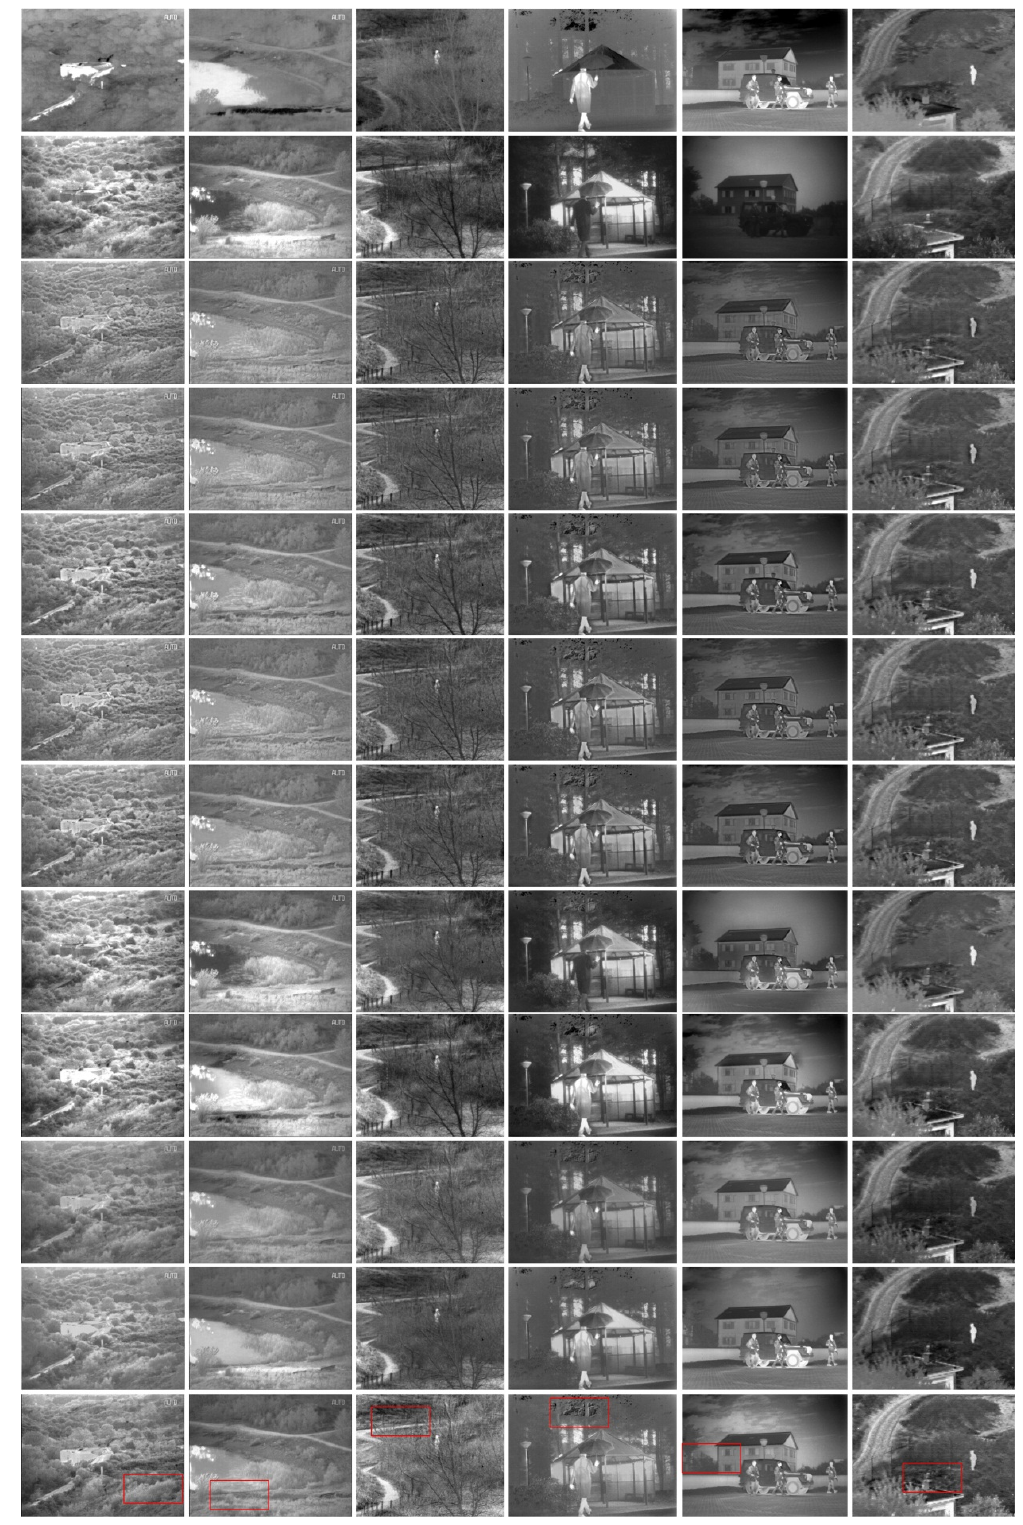
Figure 7. Fusion results of six infrared and visible image pairs. From top to bottom: infrared images, visible images, the results of curvelet transform (CVT), dual-tree complex wavelet transform (DTCWT), Laplacian pyramid (LP), nonsubsampled contourlet transform (NSCT), two-scale image fusion based on visual saliency (TSIFVS), guided filtering based fusion (GFF), convolutional neural network based fusion (CNN), Dense-add, Dense-L1, and the proposed method.